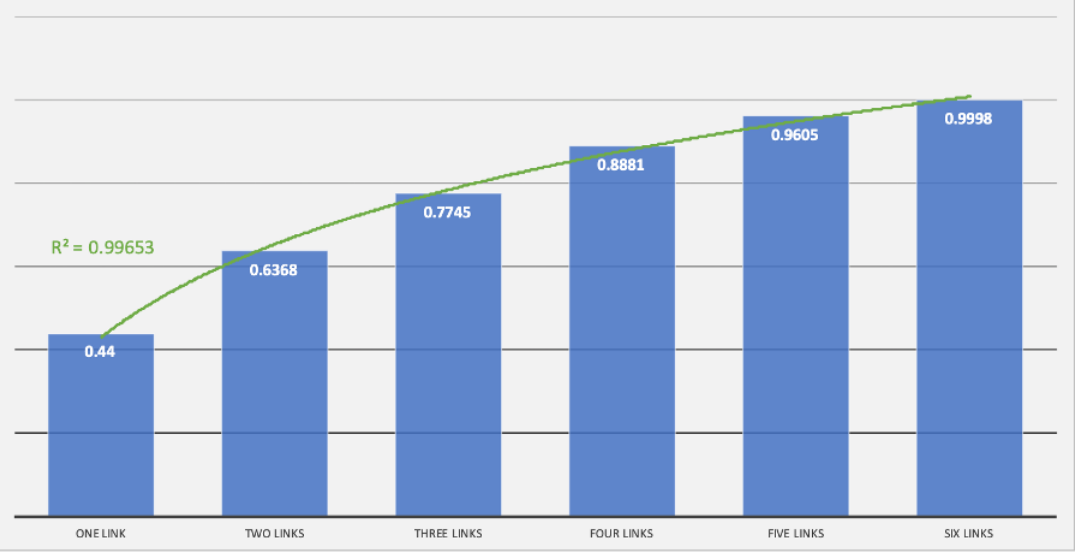
Figure 5. Accuracy of the model at incremental links.